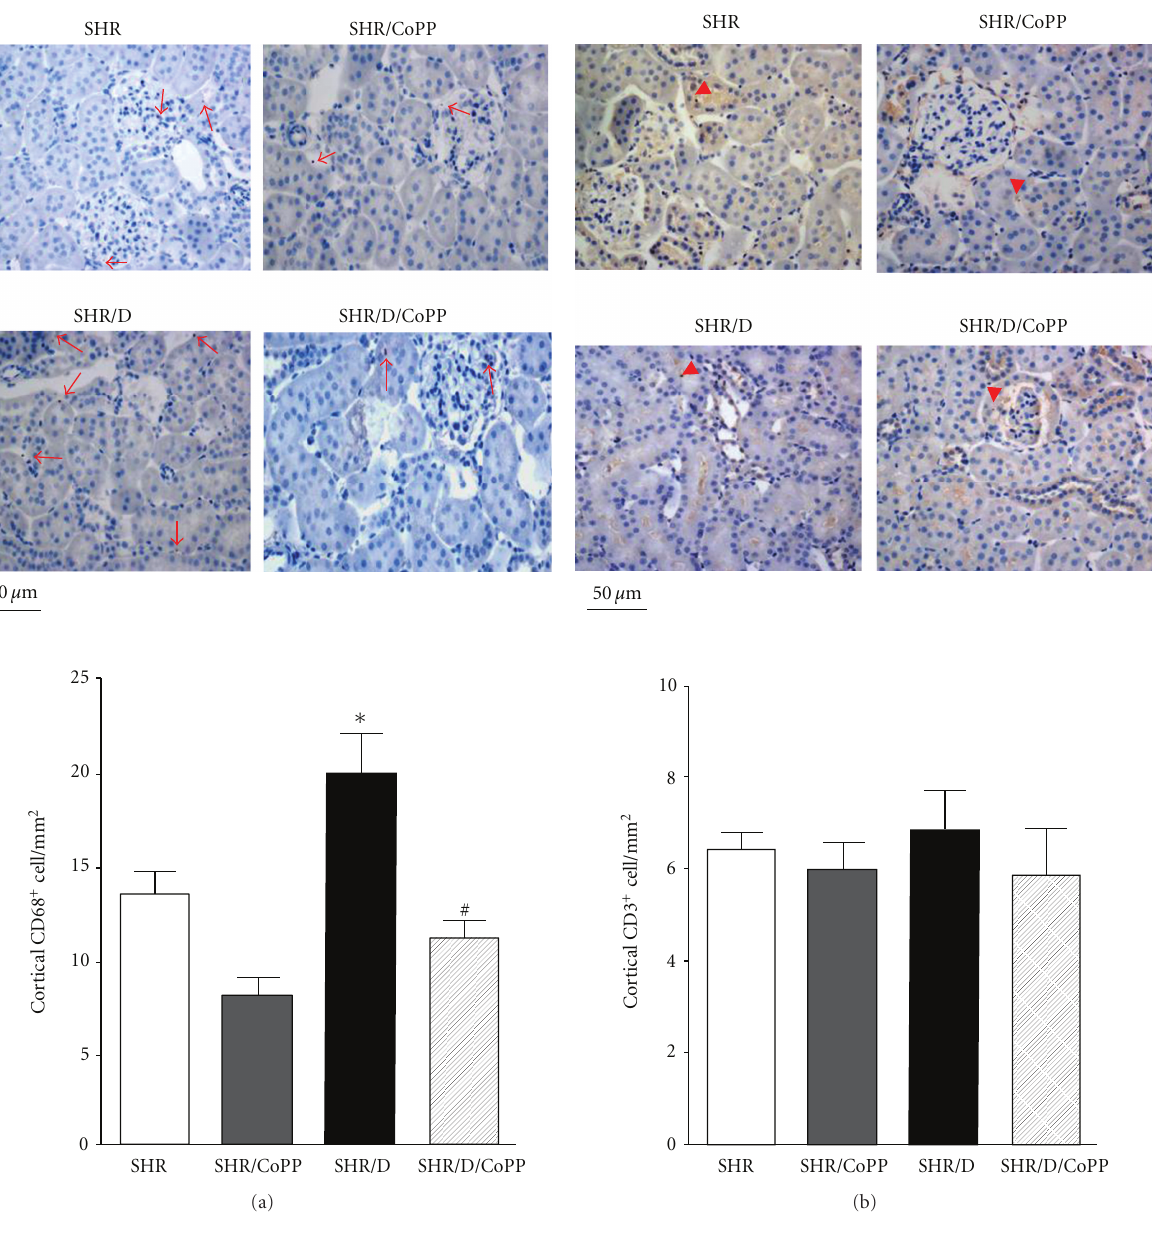
Figure 5: Representative images and average number of CD68-positive and CD3-positive cells (C) to assess monocytes/macrophages and T- cell infiltration, respectively, per 1 mm 2 in the kidney cortex of control and diabetic SHR with or without CoPP treatment ( n = 5, ∗ indicates significant di ff erence from control SHR, # indicates significant di ff erence from diabetic